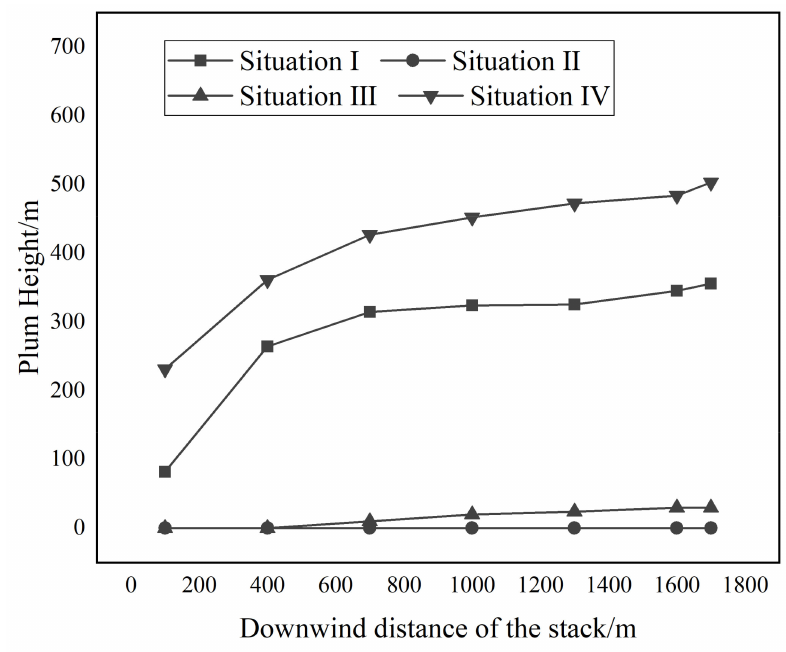
Figure 7. BL2 simulations: Different plume heights in different